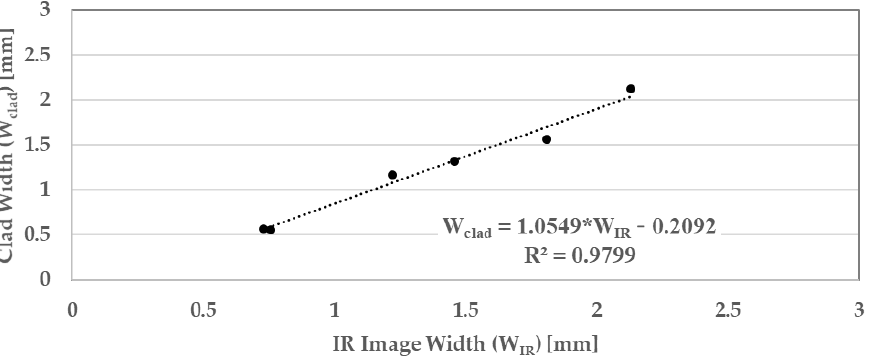
Figure 12. Correlation between IR image width (W IR ) and actual clad width (W Clad ) from experiment.